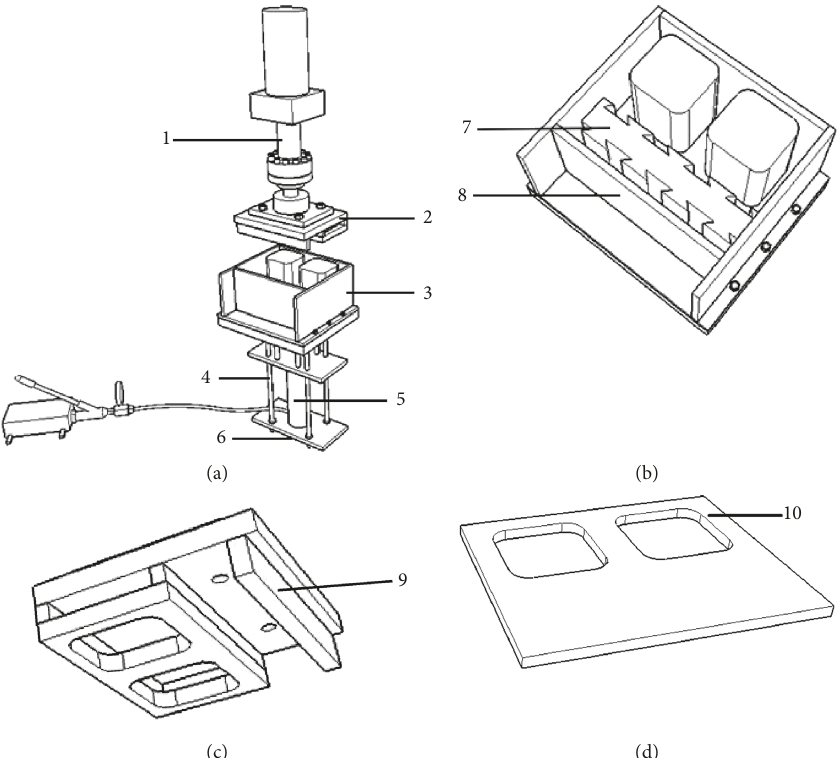
Figure 3: Block manufacturing equipment. (1) Upper hydraulic jack; (2) upper mold plate; (3) block mold; (4) supporting screw; (5) base hydraulic jack; (6) base fixing plate; (7) extruded polystyrene layer; (8) movable side plate of block mold; (9) upper mold plate; (10) block locating plate. (a) The whole block manufacturing system. (b) Details of the block mold. (c) Details of the upper block plate. (d) Details of the block support